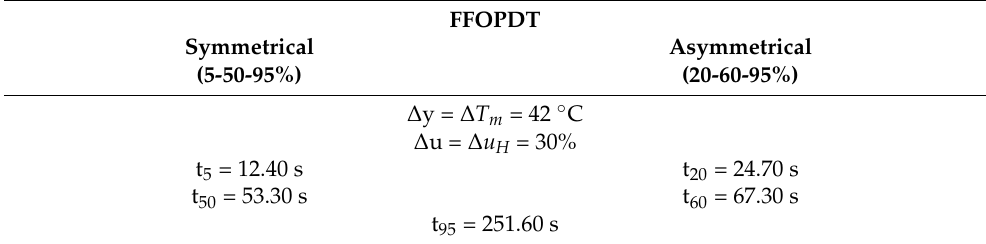
Table 6. Process information for Configuration #1 for fractional-order model identification with sets of points (5-50-95%) and (20-60-95%).